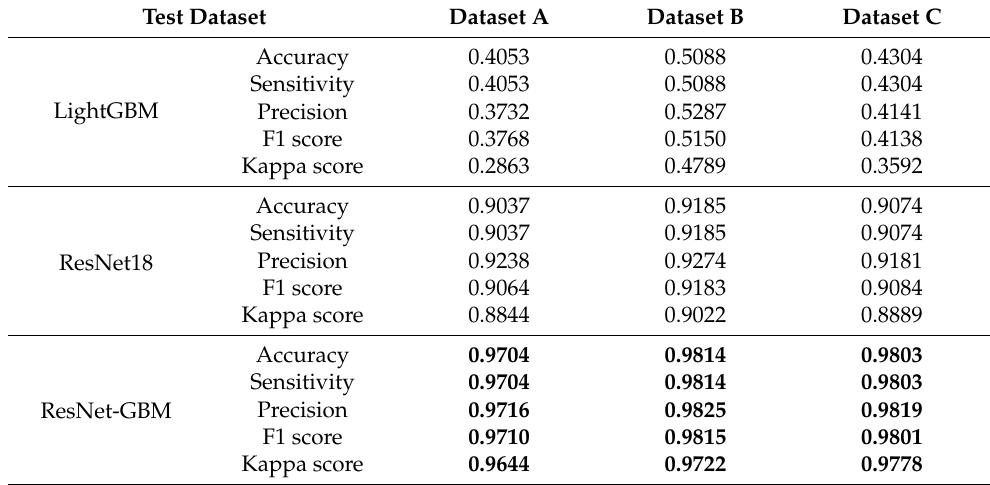
Table 5. Results of ablation